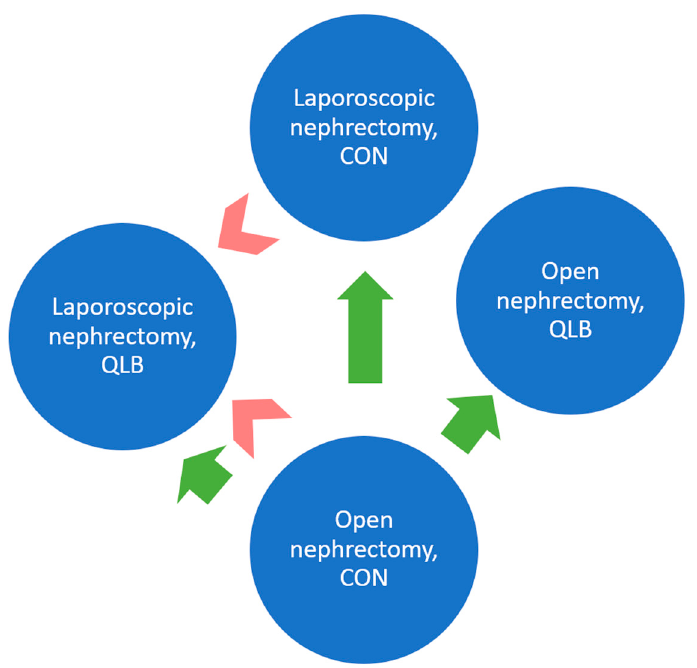
Figure 3. Persistent pain severity measured with the NPSI at months 3 and 6. Significant differences are represented by arrows pointed toward the lower pain severity at months 3 (green arrows) and 6 (red arrows). Pairwise comparisons were made with the Mann–Whitney U test using a significance level of 0.008 after Bonferroni correction. CON: control group; QLB: quadratus lumborum block